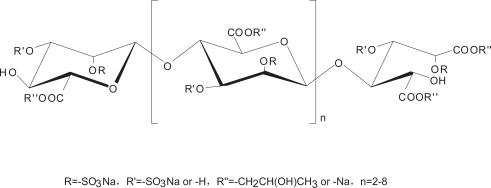
Structure of MdOS.